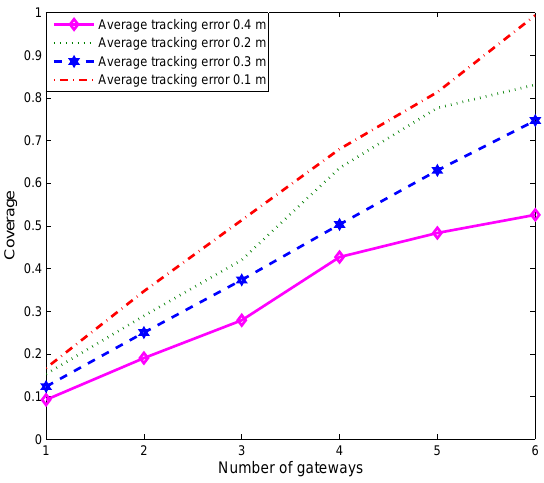
Figure 9. Impact of tracking accuracy.